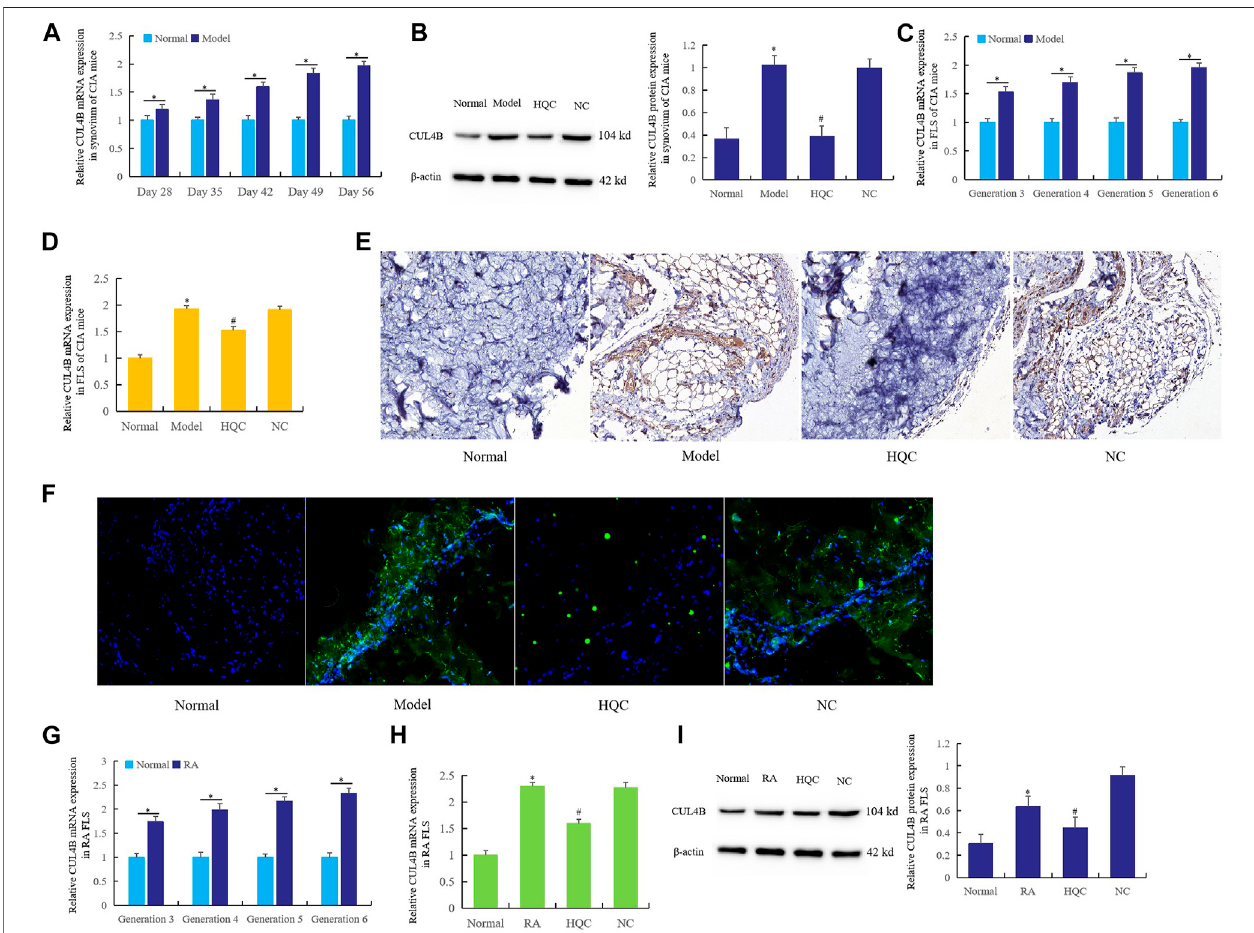
FIGURE3| HQC inhibited the CUL4B expression inCIA mice and RAFLS.The effects ofHQC on CUL4B expression wasevaluatedusing samplesfrom CIA mice and RA FLS. (A) : Ten CIA mice were killed every 7 days from the 28th day to the 56th day, then the expression of CUL4B in synovium was detected by real time qPCR; (B) : the expression of CUL4B in synovium ofCIA mice in each group was detected by western blotting; (C) : the expression of CUL4B in the third to sixth generation CIA FLS was detected by real-time qPCR; (D) : the effect of HQC on CUL4B expression was detected by real-time qPCR; (E) : the role of HQC in the expression of CUL4B wasdetectedbyimmunohistochemistry; (F) :immuno fl uorescencewasusedtodetectedtheroleofHQCintheexpressionof CUL4B , “ Normal ” isnormalgroup, “ Model ” ismodelgroup, “ HQC ” isHQCtreatmentgroup, “ NC ” isthepurewatergroupwithoutHQC; (G) :RealtimeqPCRwasusedtodetecttheexpressionof CUL4B in RA FLS; real-time qPCR (H) and western blotting (I) were used to detected the effects of HQC on the expression of CUL4B in RA FLS. For (B,C,D,H,I) , *Model/RA FLS group was compared with normal group; # HQC group was compared with model/RA FLS group.